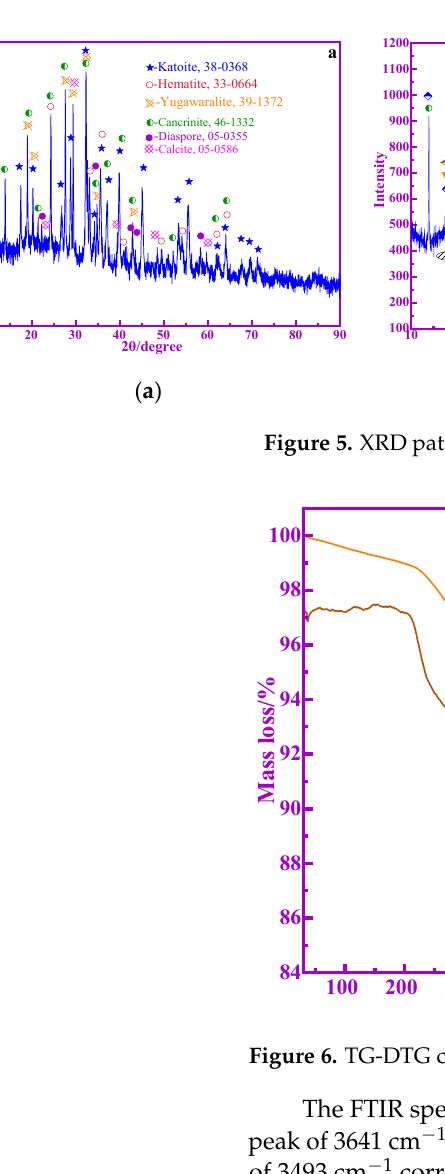
peak of 575 cm − 1 may be related to the rings of silicon oxygen and aluminum oxygen.